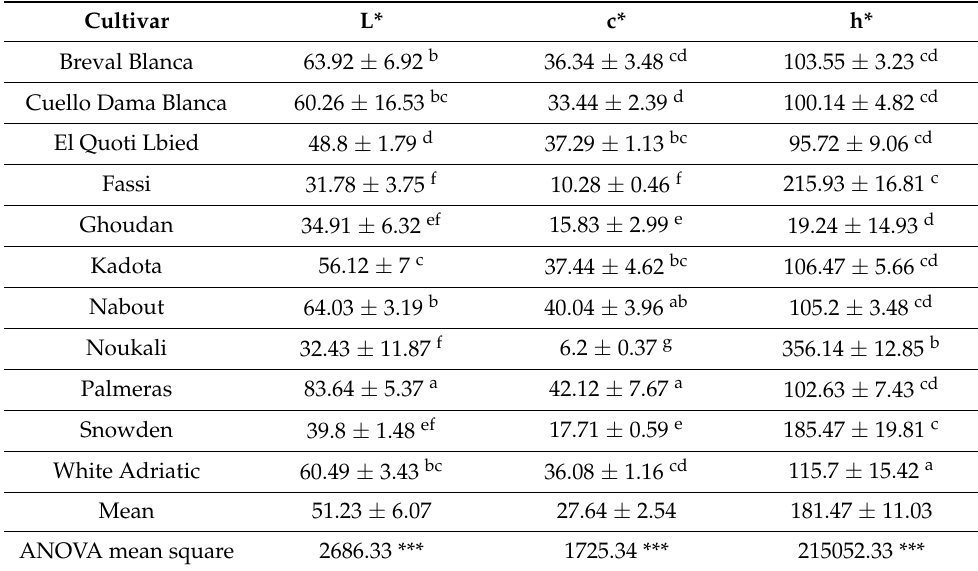
Table 3. Skin coordinate colors of studied cultivars’ fruits.